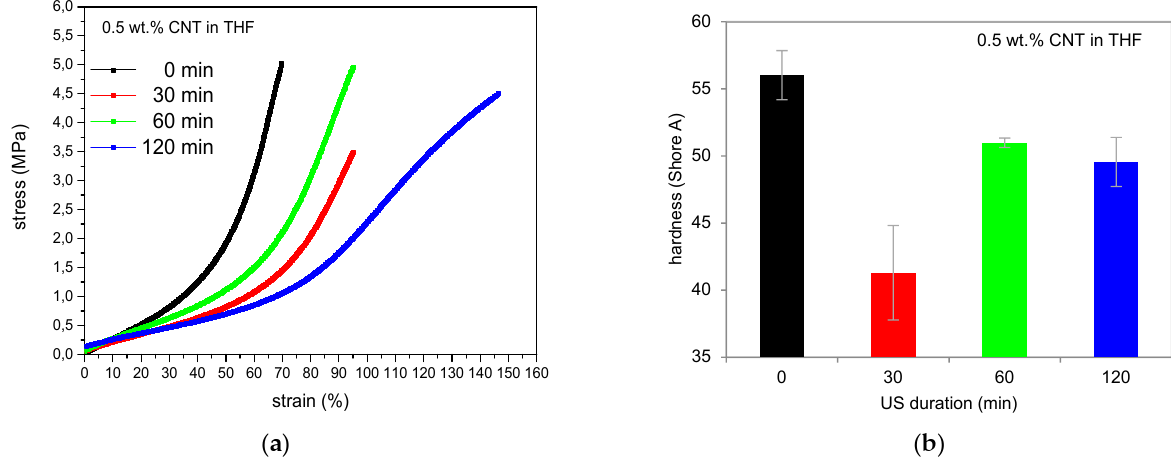
Figure 2. Mechanical behavior of polydimethylsiloxane/carbon nanotube (PDMS/CNT)-composites with pre-dispersion in THF, ( a ) stress-strain experiments and ( b ) Shore A hardness.